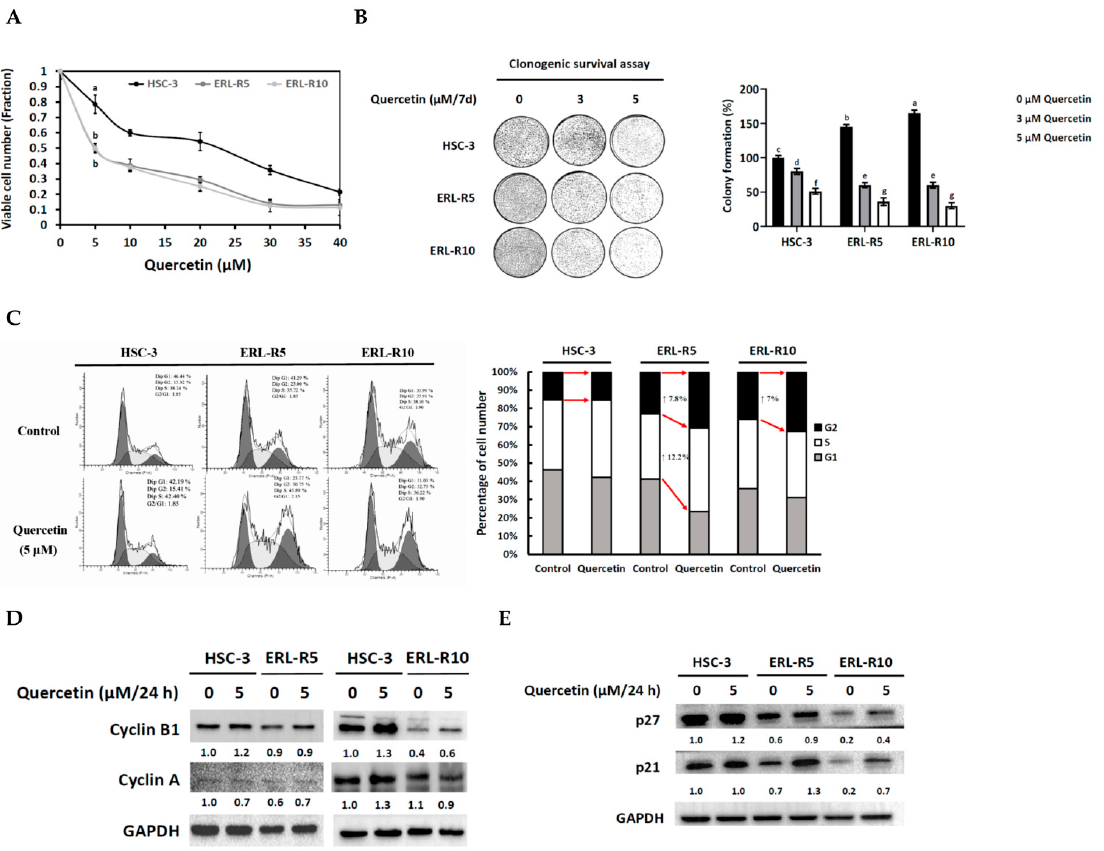
Figure 2. Erlotinib-resistant OSCC cells are sensitive to the growth-inhibitory efficacy of quercetin. ( A ) After seeded in a 6-well plate, HSC-3, ERL-R5, and ERL-R10 cells were treated with quercetin (0~40 μ M) for 72 h and viable cell number was determined by a trypan blue staining assay. Values are mean ± SD, n = 3. ab Values with different letter differ significantly at indicated time point, p < 0.05. ( B ) HSC-3, ERL-R5, and ERL-R10 cells (2 × 10 3 cells) were seeded onto a 6-well plate and cul- tured with quercetin (0, 3, 5 μ M) for 7 days. Colony formation was quantified as a percentage of the control (0 μ M quercetin). Values are mean ± SD, n = 3. abcdefg Values with different letter differ signif- icantly, p < 0.05. ( C ) HSC-3, ERL-R5, and ERL-R10 cells were cultured with the addition of quercetin (0, 5 μ M/24 h) and subjected to cell cycle analysis using a FACScan flow cytometer. ( D , E ) Cell lysates from HSC-3, ERL-R5, and ERL-R10 cells cultured with or without adding 5 μ M quercetin for 24 h were subjected to Western blot analysis for indicated proteins.